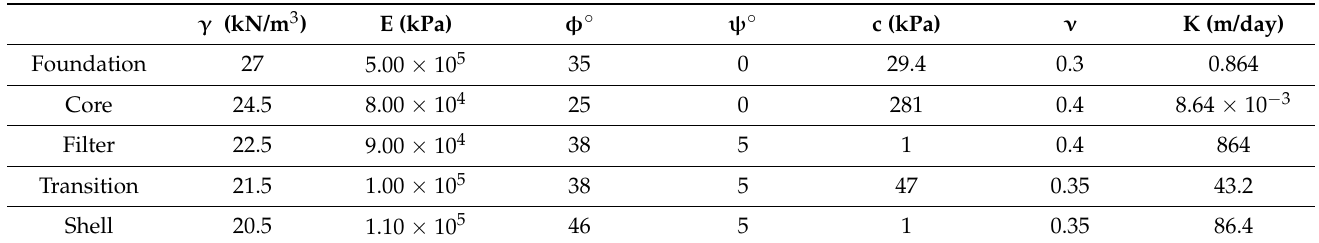
Table 1. Mohr–Coulomb